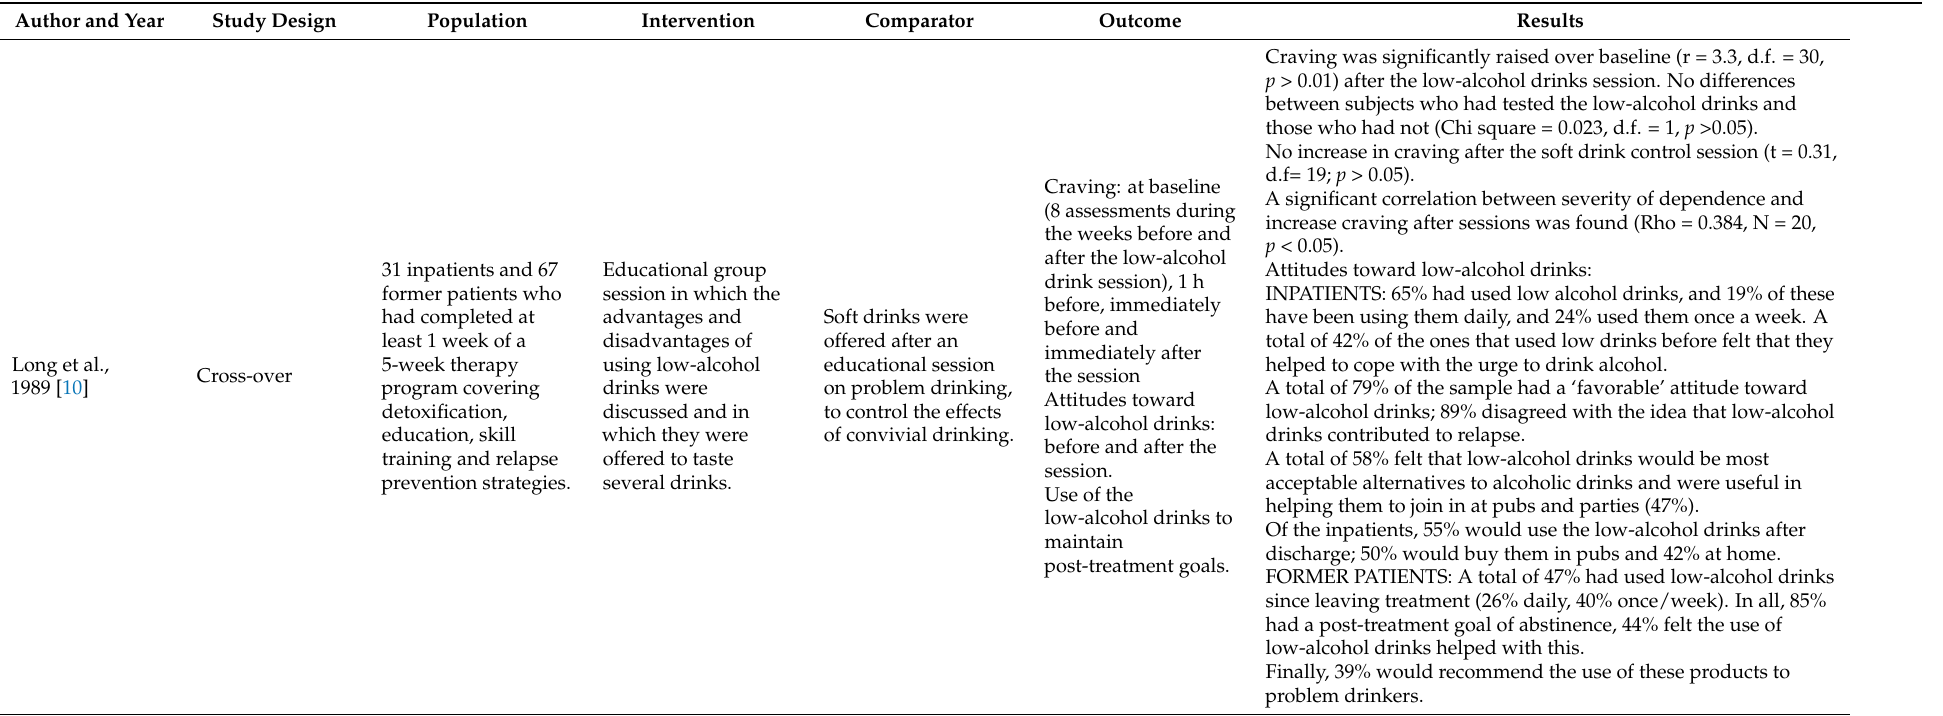
Table 2. Summary of the included articles on the use of NoLo products in patients with AUD, heavy or high-risk